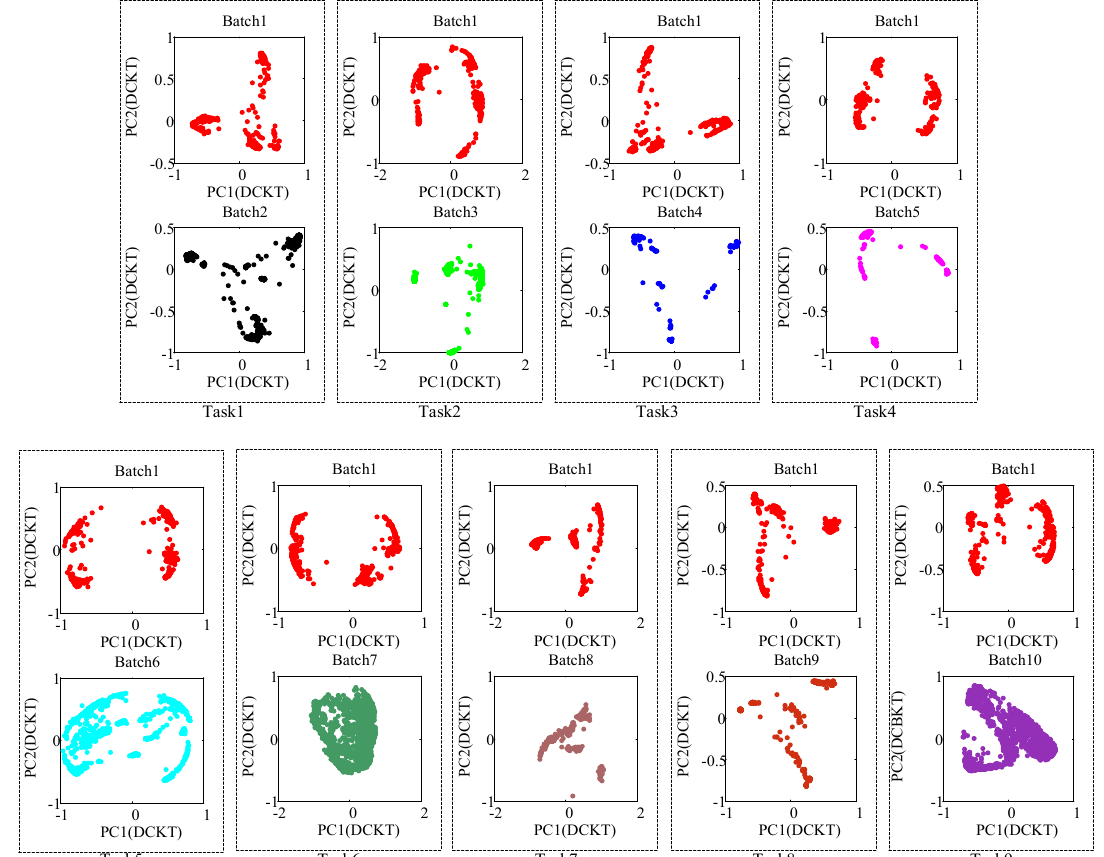
Figure 4. Principal components (PC1 vs. PC2) of the source domain and the target domain after DCKT (i.e., the 2-D subspace distribution of 9 tasks, respectively). In each task, the top picture is the Batch 1 (source domain) after DCKT and the picture below is the Batch i (target domain) after DCKT, from it we can find that the distribution of source domain and target domain is more similar after DCKT.